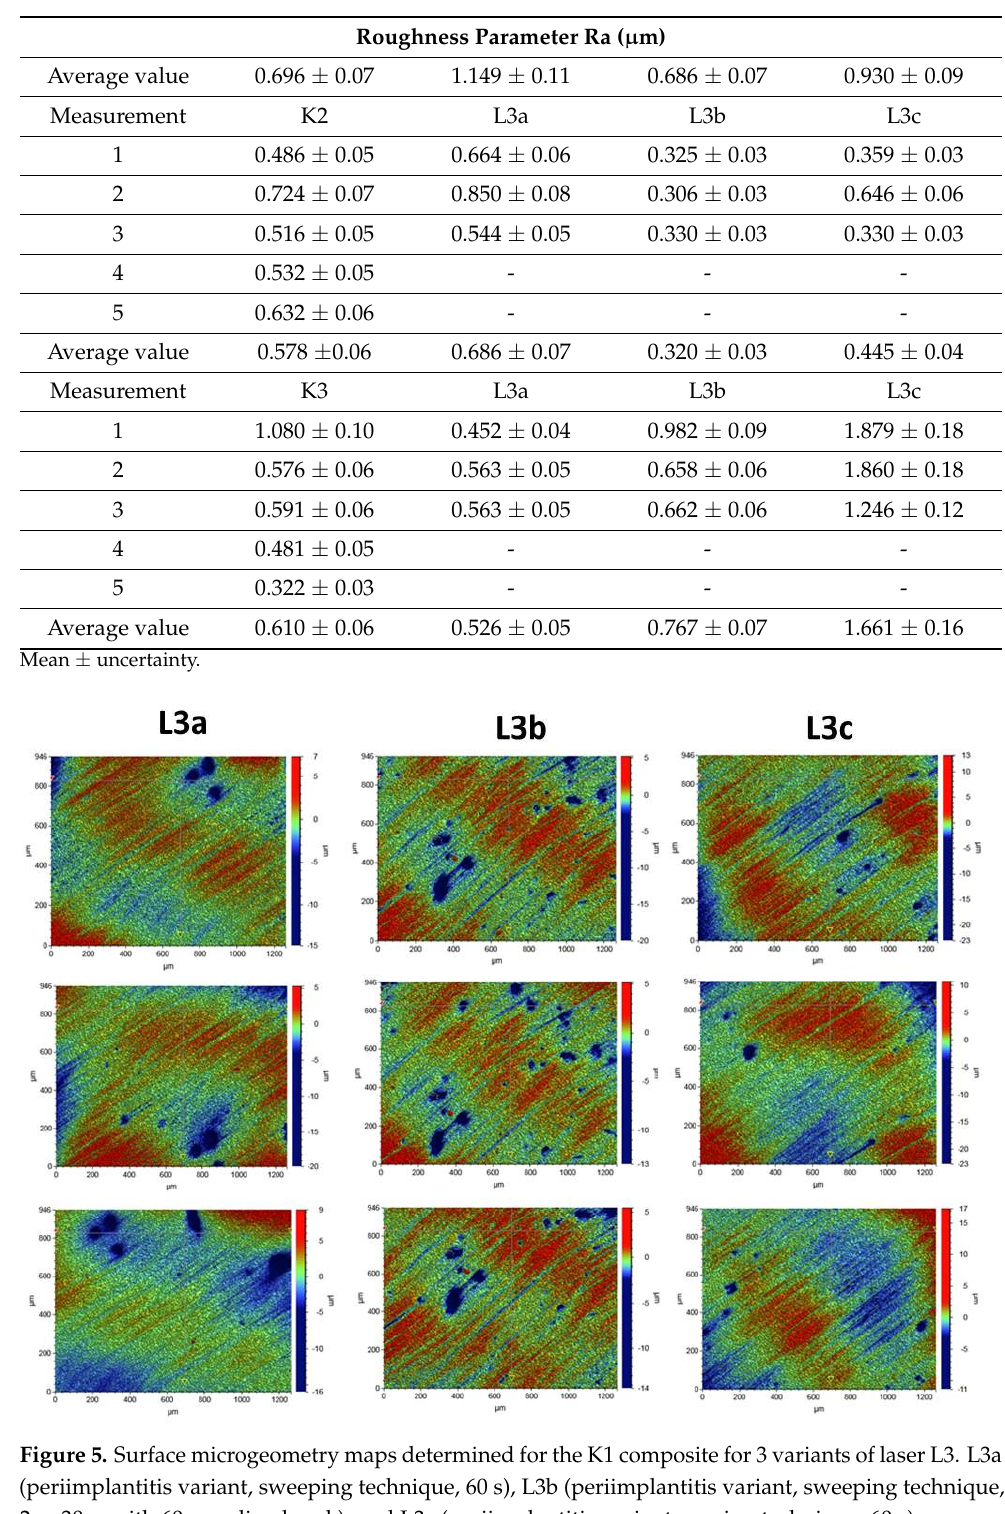
Figure 6. Surface microgeometry maps determined for the K2 composite for 3 variants of laser L3. L3a (periimplantitis variant, sweep technique, 60 s), L3b (periimplantitis variant, sweep technique, 2 × 30s with 60 s cooling break) and L3c (periimplantitis variant, scoring technique, 60 s).